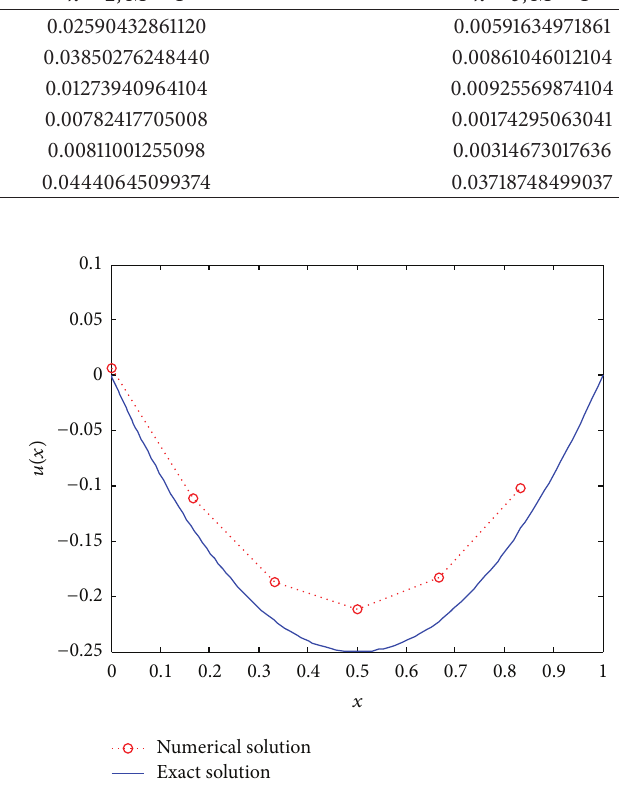
Figure 1: The comparison between numerical and exact solution for 𝑘 = 1 , 𝑀 = 1 .